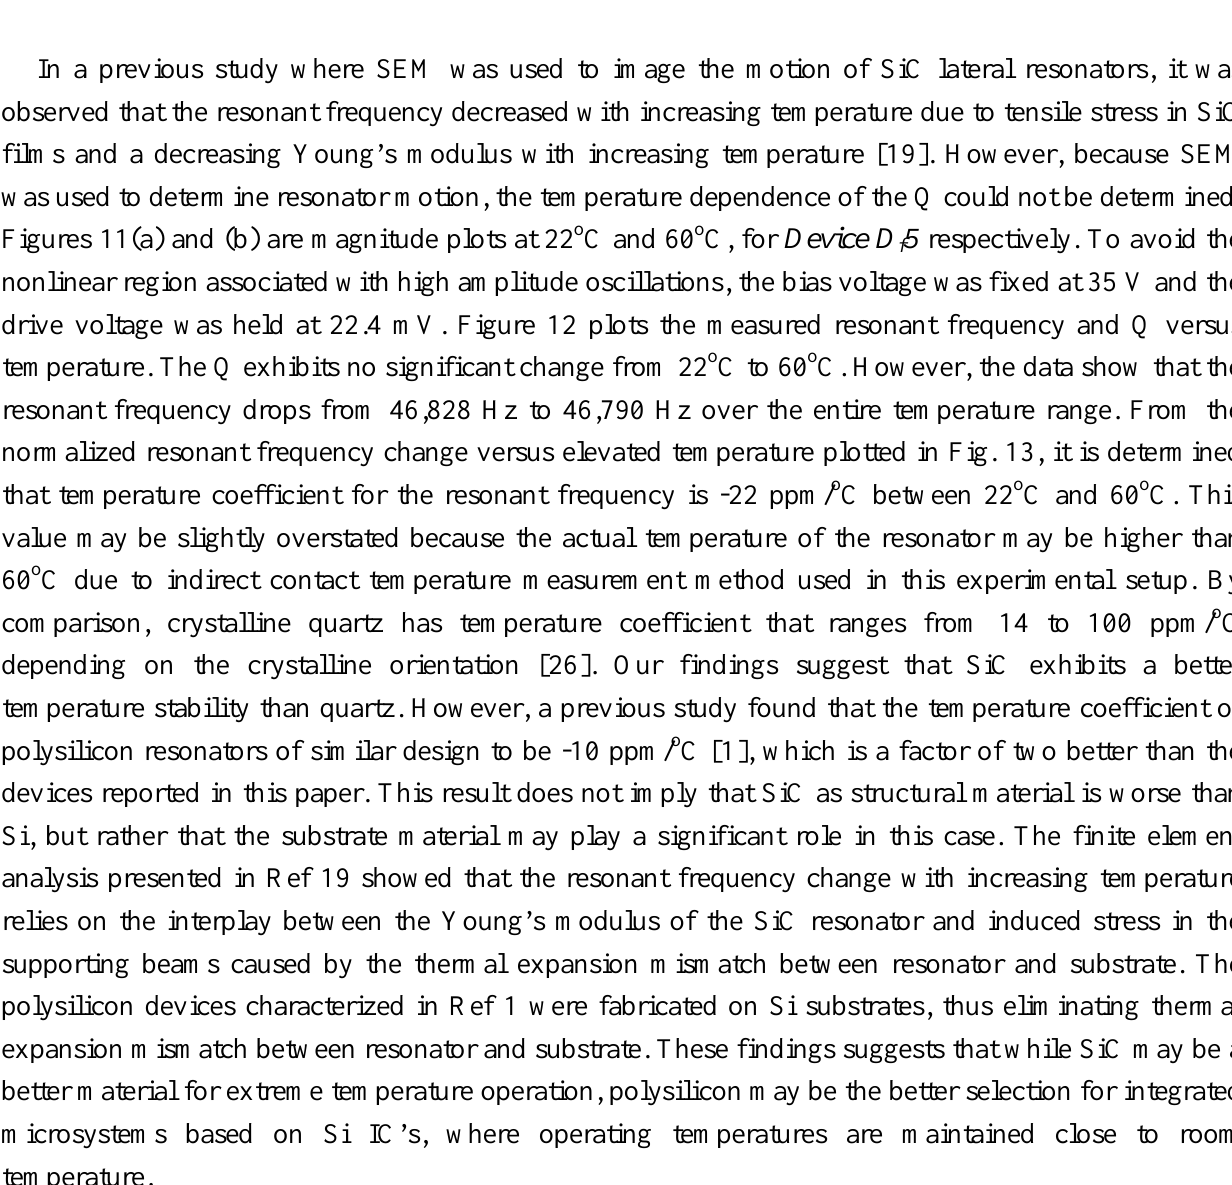
Figure 11. Magnitude plots at 22 o C and 60 o C for Device D